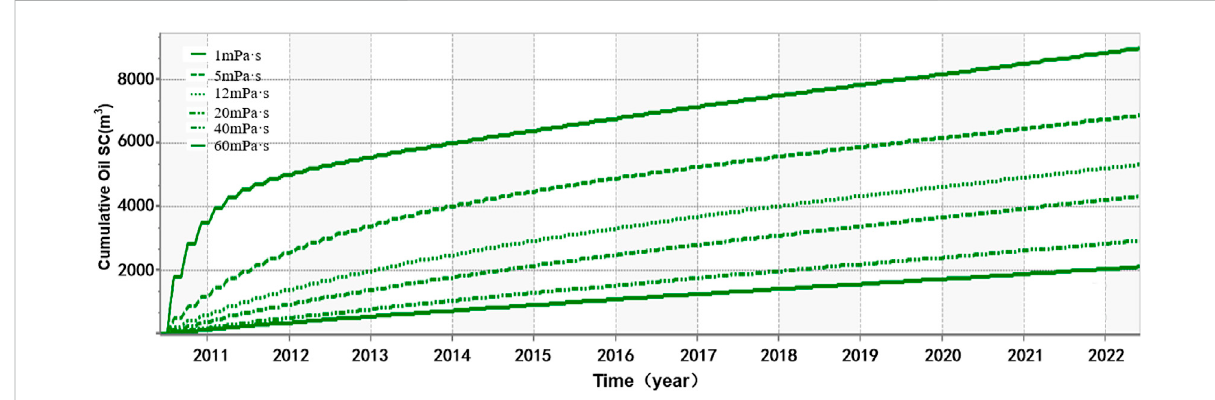
FIGURE 9 Cumulative oil production versus oil to water viscosity ratio